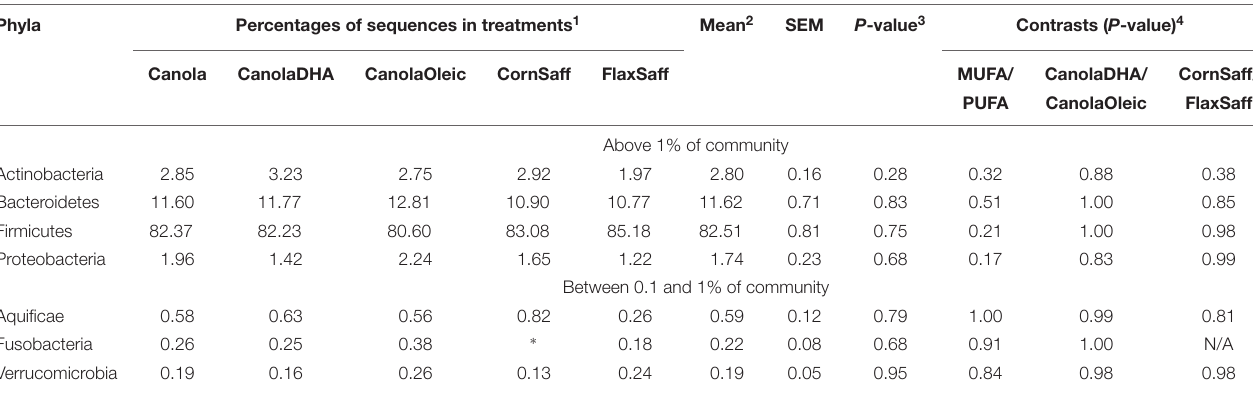
TABLE 3 | Relative abundances of bacterial phyla from 16S rRNA gene